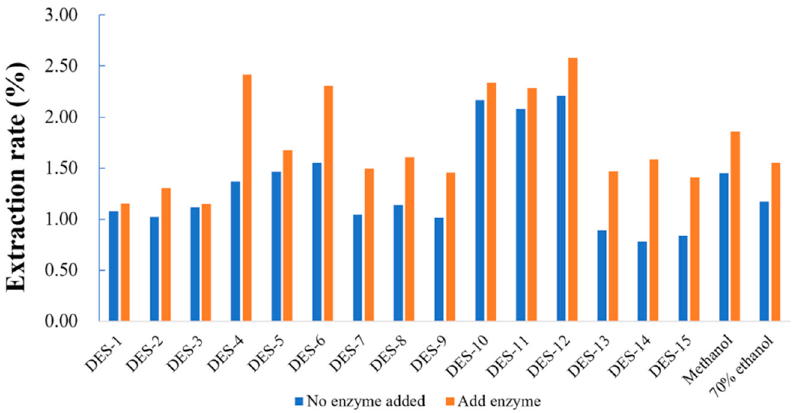
Figure 1. Extraction yield of total coumarins using different organic solvents and DESs.